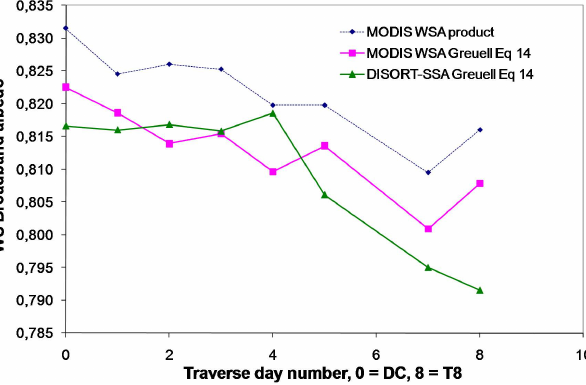
Fig. 18. Comparison of broadband albedos along the traverse calcu- lated using three methods: (i) MODIS White Sky Albedo product; (ii) the empirical equation of Greuell and Oerlemans (2004) which uses MODIS data for bands 1, 2 and 4; (iii) the empirical equation of Greuell and Oerlemans (2004) using data for bands 1, 2 and 4 calculated from our snow data and DISORT.